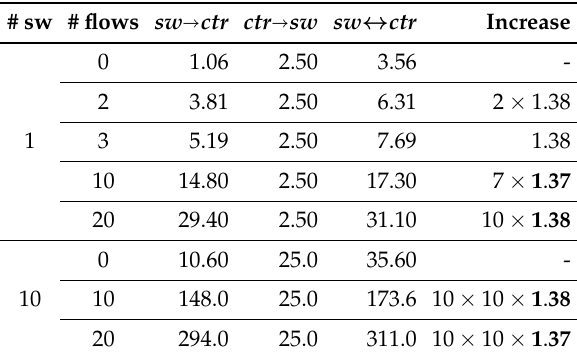
Table 1. The Ctr–Sw bandwidth requirements in kbps for a Kandoo controller. Columns sw ctr sw refer to the traffic sent from the sw(itch) to the c(on)tr(oller) and the opposite. (cid:1)